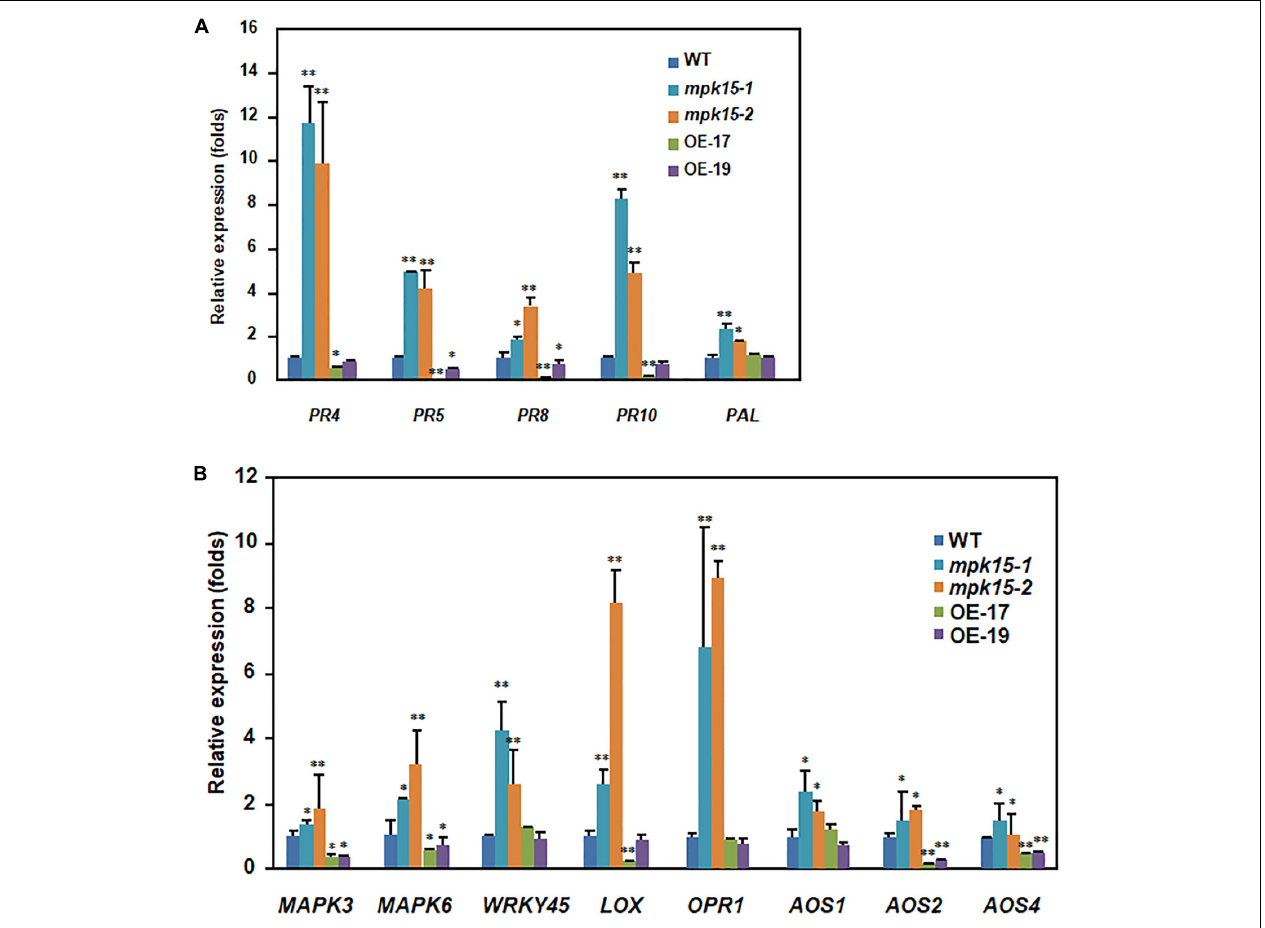
FIGURE 6 | Expression pattern of defense signaling genes in the WT, mpk15 mutant, and OsMPK15-OE lines. The 30-day-old seedlings samples of different lines under normal conditions were used for qRT-PCR analyses. (A) The expression pattern of pathogenesis-related ( PR ) genes includes PR4 , PR5 , PR8 , PR10 , and PAL . (B) Expression pattern of the MPK3 , MPK6 , SA-mediated signaling marker gene WRKY45 , and JA biosynthesis genes include LOX , OPR1 , AOS1 , AOS2 , and AOS4 . Data presented are the mean ± SD from three independent experiments. ∗ P ≤ 0.05; ∗∗ P ≤ 0.01 (Student’s t